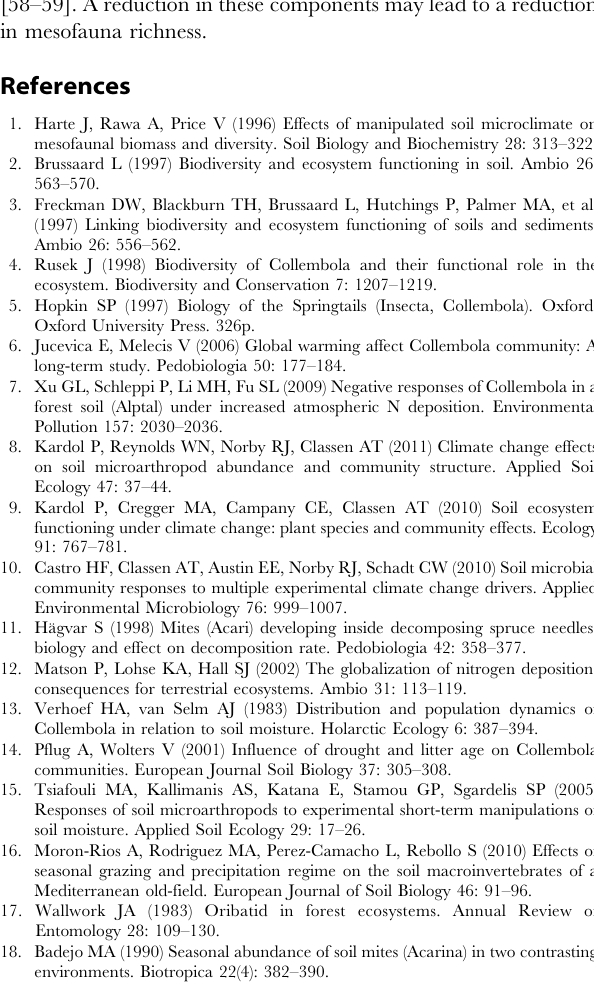
(Table 1). Over a three-year period the trees grew better on acidic than on calcareous soils, therefore consuming more water, these characteristics disappeared when drought was imposed, indicating stronger drought effects on trees grown in acidic than in alkaline soil [31]. Common beans are reported to grow longer roots and extract more soil moisture as an important mechanism to cope with soil water [60]. The roots of drought-tolerant bean species reached a soil depth of 1.3 m under drought stress at Palmira (soil pH 7.7), while the roots extended only to 0.7 m under acid soil conditions at Quilichao (soil pH 5.0) [60]. This suggests that the mechanism to cope with drought was inhibited in acidic soil. In conclusion, it seems that mesofauna are sensitive to air warming and drought, particularly in acidic